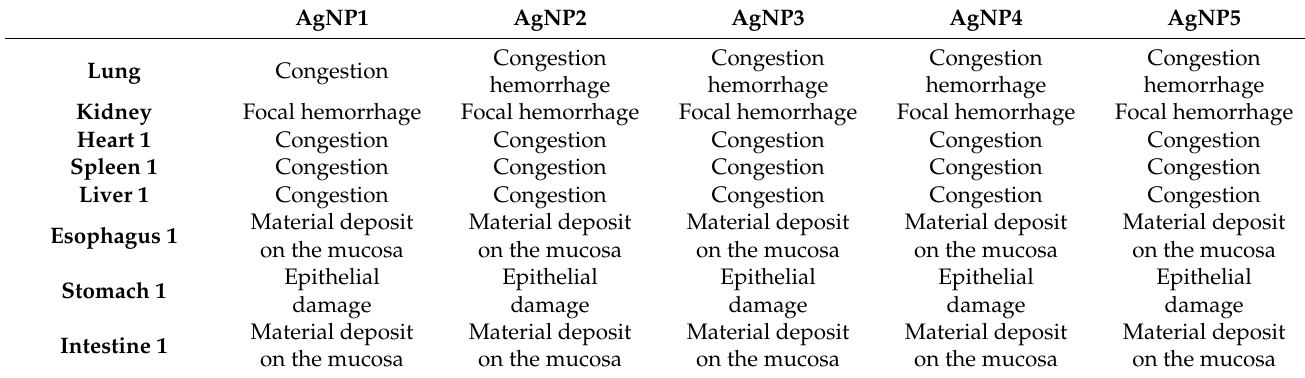
Table 3. Histological findings in organs from mice exposed to